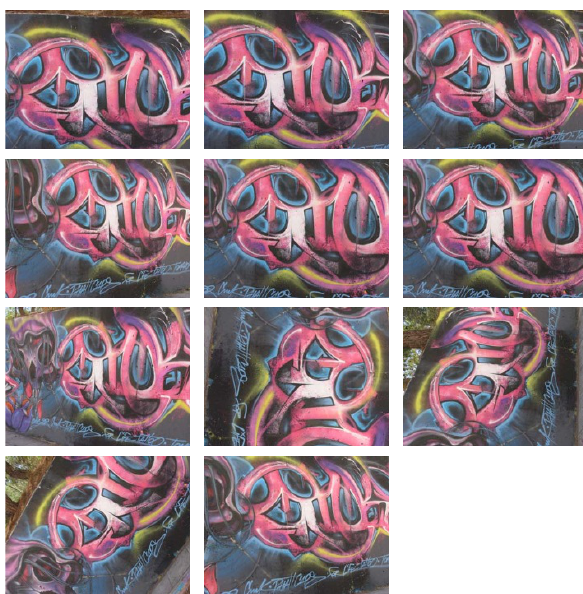
Figure 2. Image set 2 (‘fronto-parallel’ is the first image). Table 2. Calibration results for image set 2